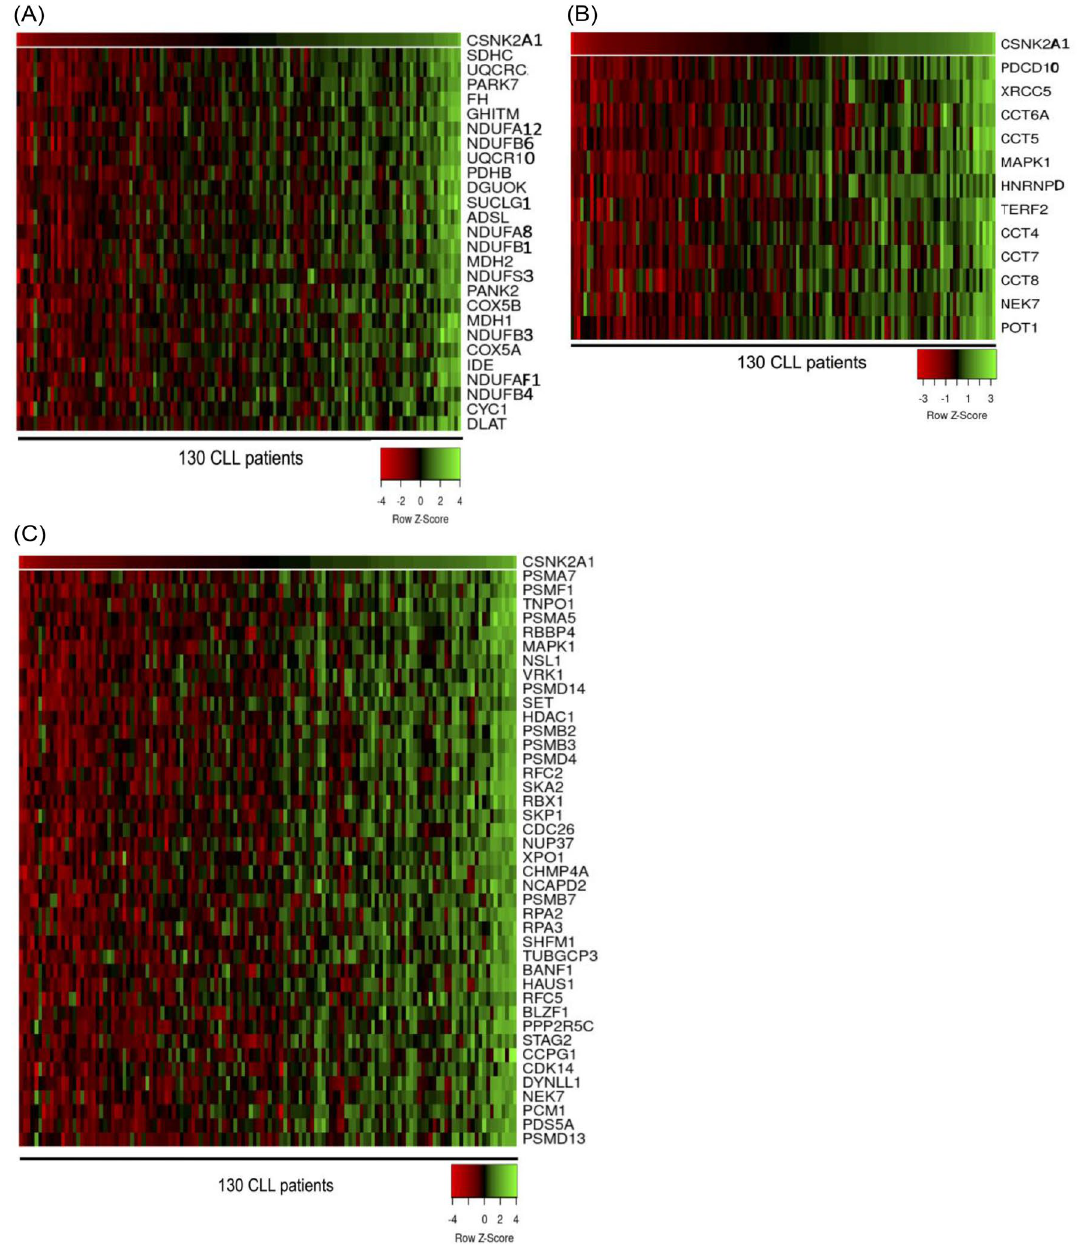
Figure 3. Heatmap presentation of the correlation between the expression of CSNK2A1 and the expression of genes that enriched CLL-related pathways. The expression CSNK2A1 was shown at the top of each heatmap; and patients (n = 130) were sorted from the least expression (red color) to the highest expression (green color) of CSNK2A1 . Heatmap ( A ) shows the correlation between the expression CSNK2A1 and the expression of aerobic respiration genes (Pearson score = 0.77–0.60; p value < 0.00001). Heatmap ( B ) demonstrates the correlation between the expression CSNK2A1 and the expression of genes that positively regulate telomere maintenance (Pearson score = 0.81–0.60; p value < 0.00001). Heatmap ( C ) presents the correlation between the expression CSNK2A1 and the expression of cell cycle mitotic genes (Pearson score = 0.71–0.60; p value < 0.00001). The correlation analysis was conducted on the CLL transcriptomics data set (GSE39671). Color scale: red is low expression; green is high Root-mean-square fluctuation. Further, the flexibility and mobility of the human protein kinase CK2α subunit protein amino acid residues were assessed, in contrast to a reference structure. A large RMSF value indicates flexibility, loose bonding, or the presence of loops in the protein structure; a low RMSF value indicates stability as well as the prevalence of secondary structural elements such as sheets and helices 131,132 . In RMSF plot, the α-helical and β-strand portions are shown in red and blue color shades, respectively, while the loop area is shown in white. The RMSF values varied from 0.8 to 4.0 Å, 0.7 to 2.5 Å and 0.6 to 3.1 Å for the Silmitasertib-